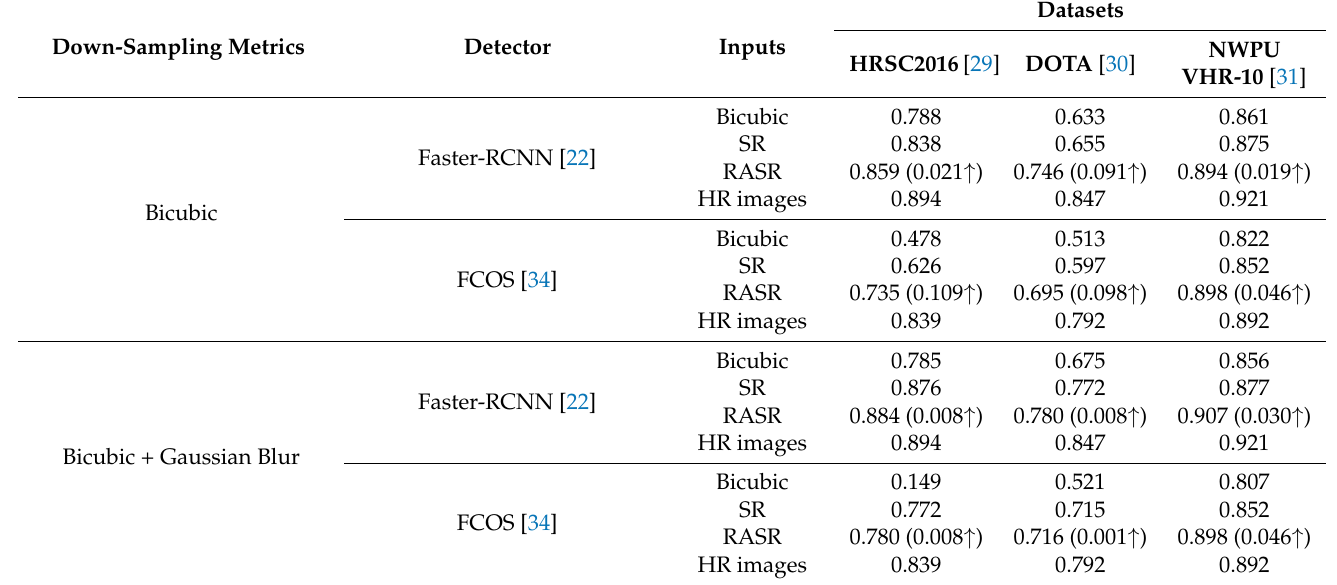
Table 2. Quantitative evaluation results of detection performance achieved by different variants of our proposed RASR. We use Faster-RCNN (with ResNet50 as backbone) and FCOS (with ResNet101 as backbone) as the evaluation detectors, and use AP 50 as the evaluation indices. Note that, the im- provement of RASR compared to SR module is shown in the